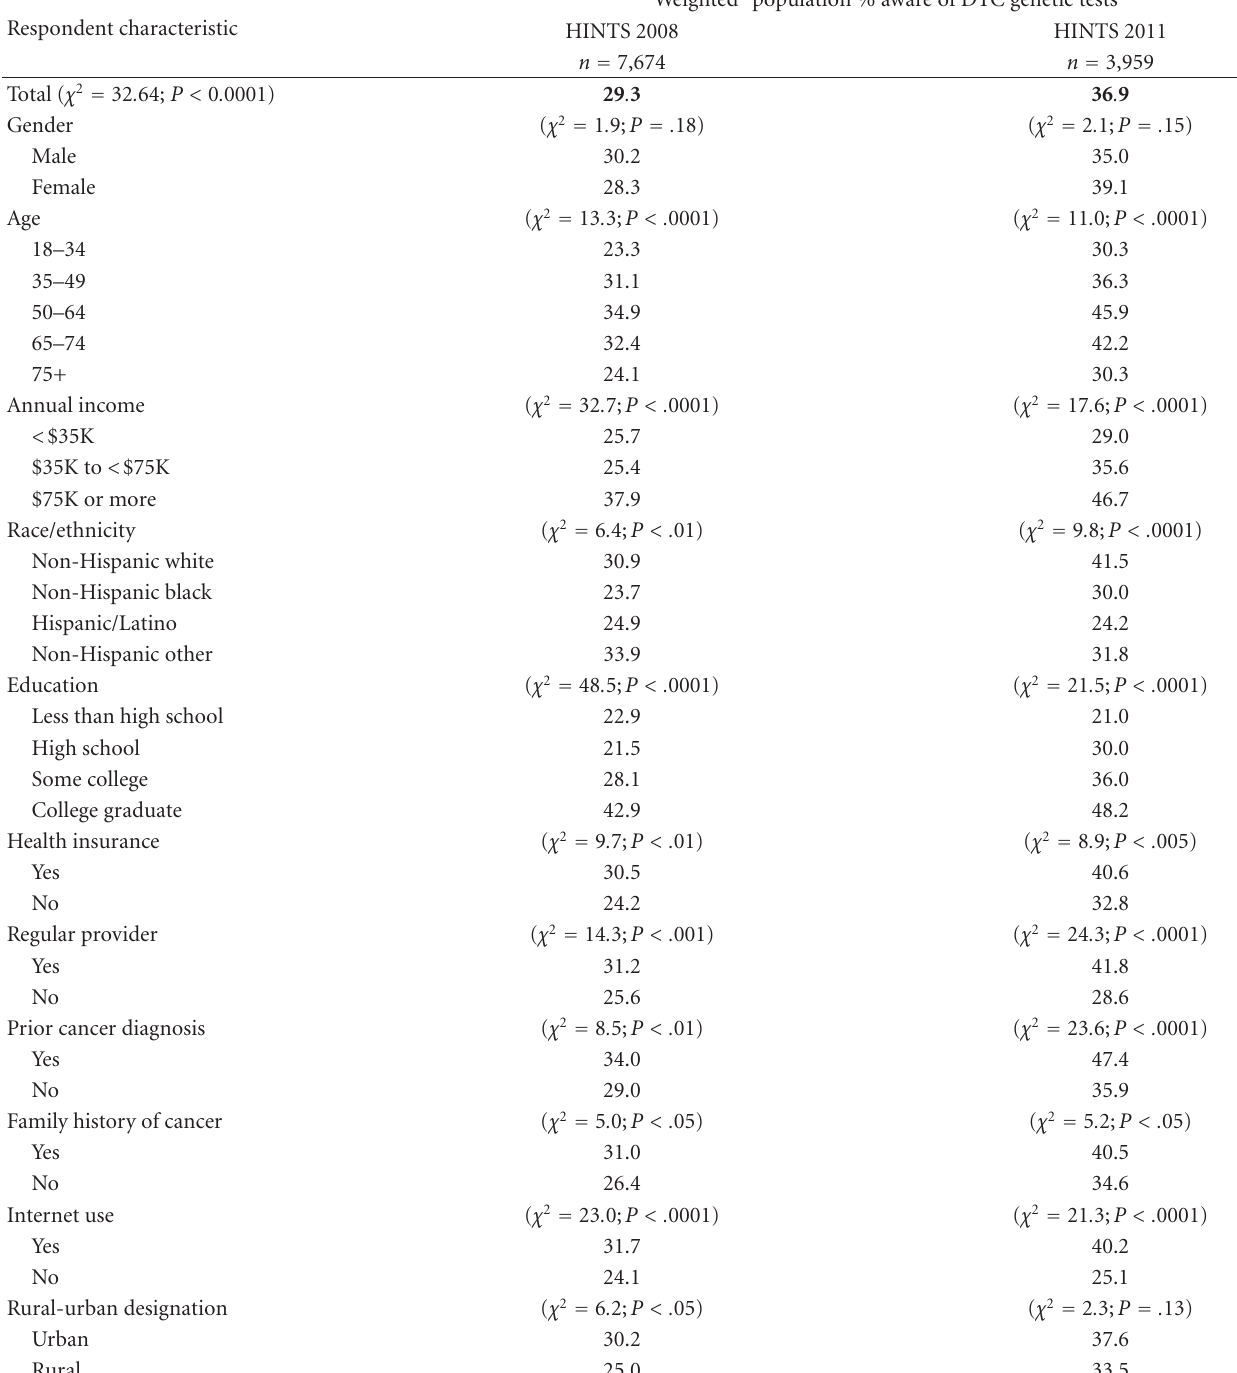
Table 1: Awareness of direct-to-consumer genetic testing by respondent